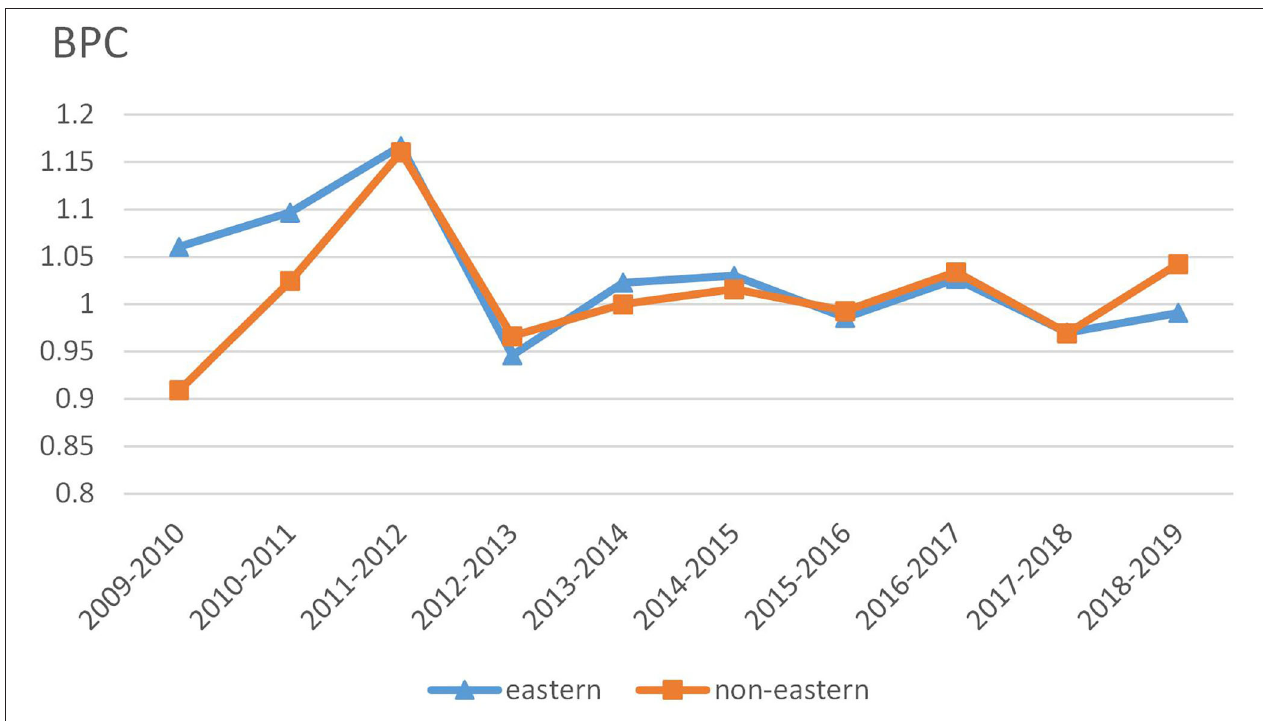
FIGURE 5 | Trends of BPC at the regional